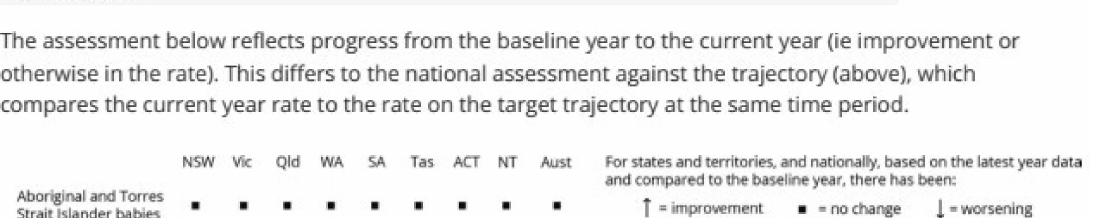
Figure 2. By 2031, increase the proportion of Aboriginal and Torres Strait Islander babies with a healthy birthweight to 91 percent. Nationally in 2018, 88.9 percent of Aboriginal and Torres Strait Islander babies born were of a healthy birthweight. This is similar to 2017 (the baseline year). Source: